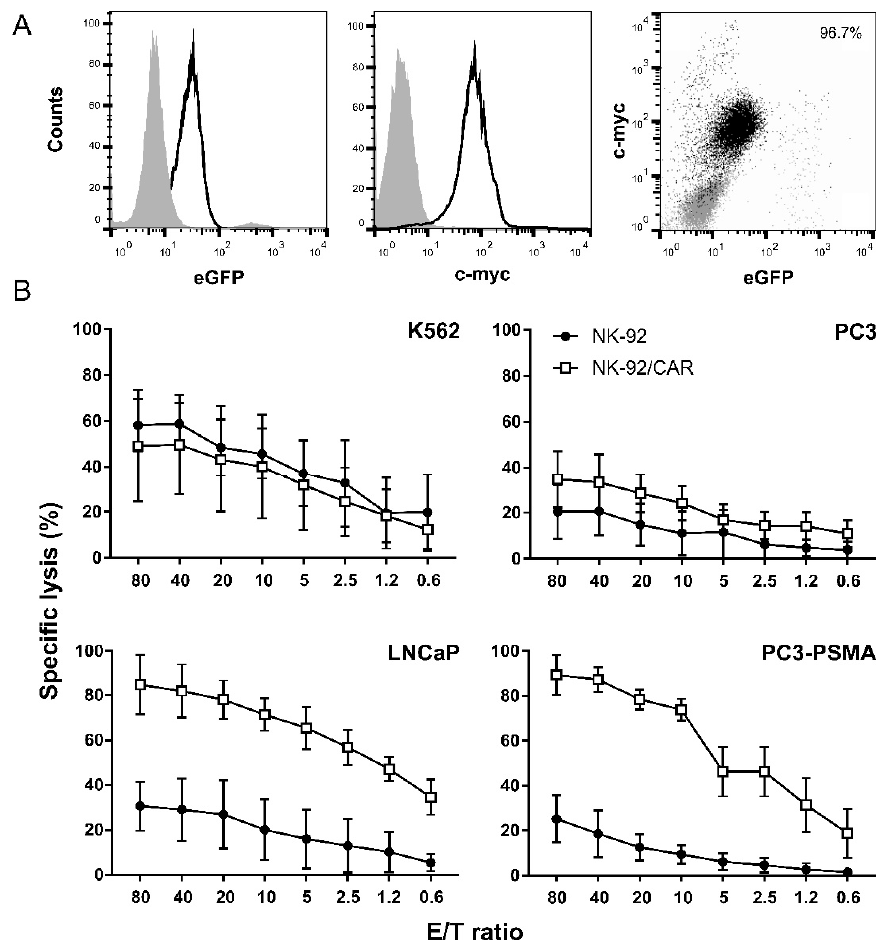
Figure 1. Anti-PSMA (prostate-specific membrane antigen) CAR (chimeric antigen receptors)-engineered NK-92 cells acquire high and specific cytotoxicity to antigen-expressing cancer cells. ( A ) CAR surface expression on a NK-92/CAR eGFP-based sorted and enriched population was determined by flow cytometry with an antibody to a Myc tag present in the CAR moiety [19]. Left and central panels, eGFP and c-myc expression in the sorted population, respectively (open areas); parental NK-92 cells for eGFP expression and an isotype antibody for c-myc analysis served as controls (shaded areas). Right dot plot reports the events gated on total viable cells. ( B ) Cytotoxicity by NK-92/CAR (open squares) was investigated in 51 Cr-release assays using as targets PSMA-negative K562 and PC3 cells (upper panels), and PSMA-expressing LNCaP and PC3 (bottom panels) cells. Parental NK-92 cells were included for comparison (full circles). Results are reported as mean values ± SD (n = 3) at di ff erent e ff ector to target (E / T)